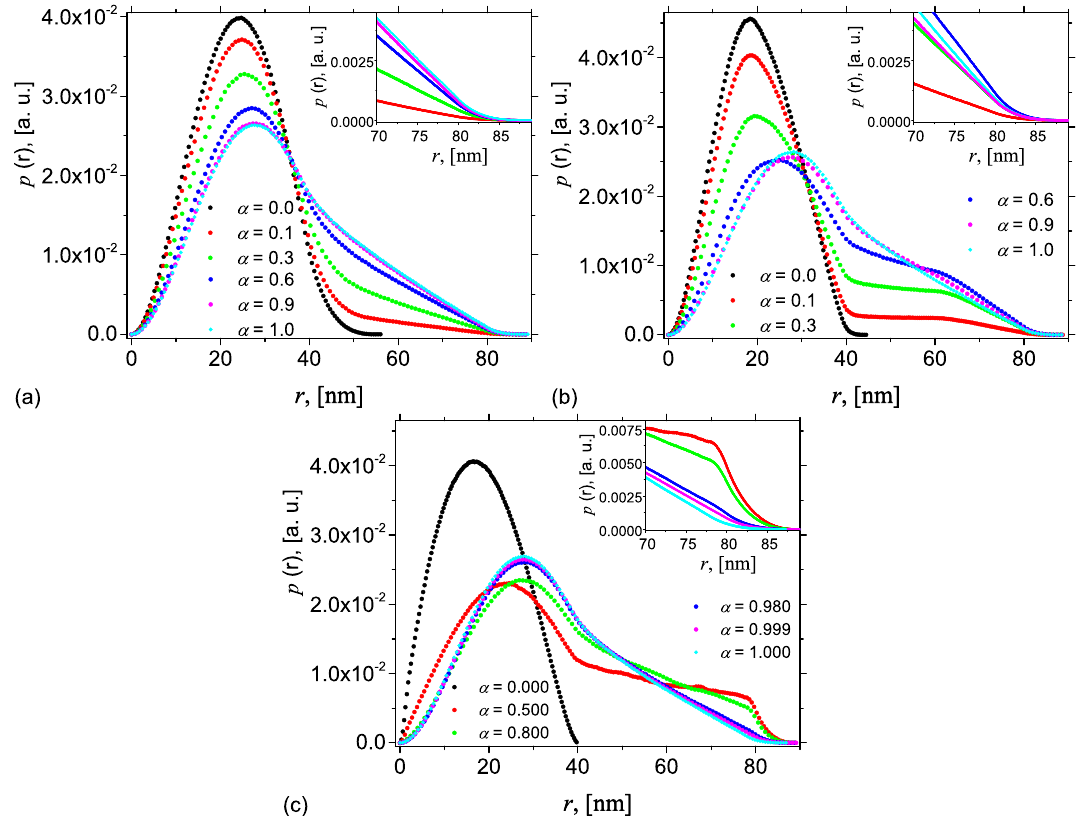
Figure A1. (Color online) Pddf p ( r ) from radially symmetric cylinders with diameter 2 a = 40 nm and height 2 L 0 = 80 nm calculated using the Monte-Carlo simulations, when Region 2 is found at various heights h above a middle-plane parallel to the bases: ( a ) h = 0 nm; ( b ) h = 20 nm; and ( c ) h = 38